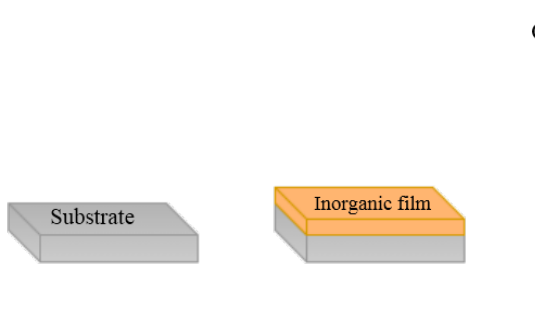
sor is deposited on a substrate by a solution method. This film is then exposed to the vapor of the second precursor (Figure 4) [8]. The perovskite film obtained by this tech- nique has a complete surface coverage, a uniform grain structure with particle size up to micrometers, and 100% precursor transformation [1]. The vapor assisted solution process (VASP) is a simple, controllable and versatile ap- proach to obtain high quality perovskite layers and results in high-performance photovoltaic